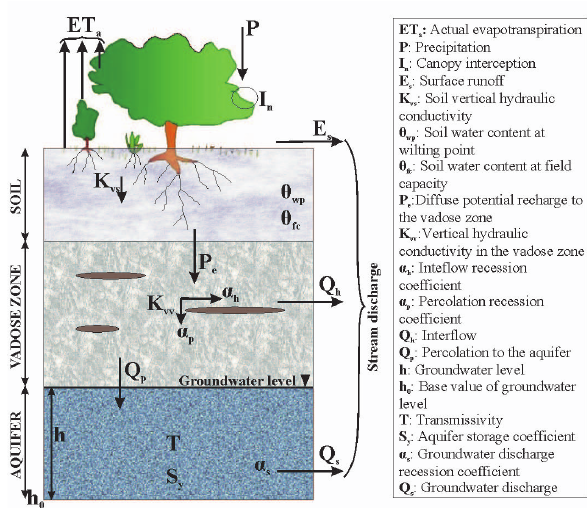
Fig. 2. Main components of water balance considered under the framework of the computer program Visual Balan (Samper et al.,